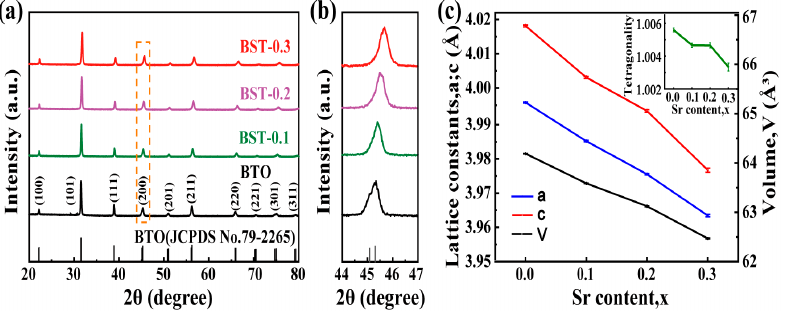
Figure 1. XRD patterns of Ba 1 ‐ x Sr x TiO 3 (0 ≤ x ≤ 0.3) nanopowders in the 2 θ ranges of ( a ) 20° to 80° and ( b ) 44° to 47°; ( c ) evolution of lattice constants ( a , c ), cell volume (V), and tetragonality (c/a, insert) with different Sr contents.